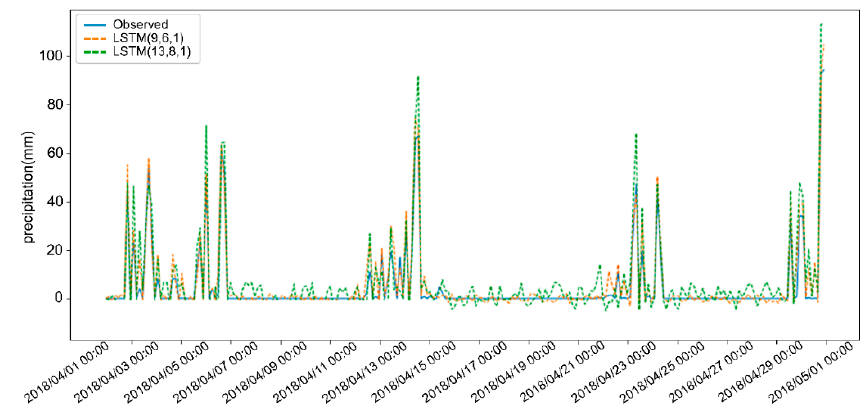
Figure 3. Three-hour precipitation predictions by LSTM (9,6,1) and LSTM (13,8,1).